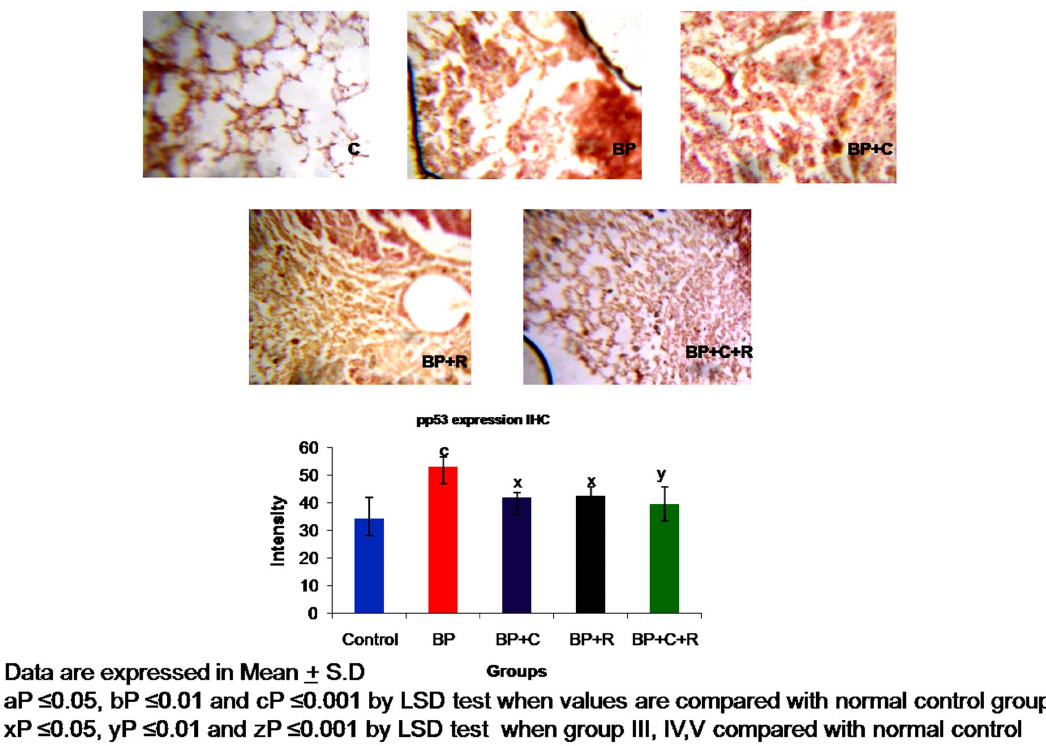
Figure 4. Effects of curcumin and resveratrol on protein expression of phoshorylated p53[ser-15] by western blot analysis during lung carcinogenesis.